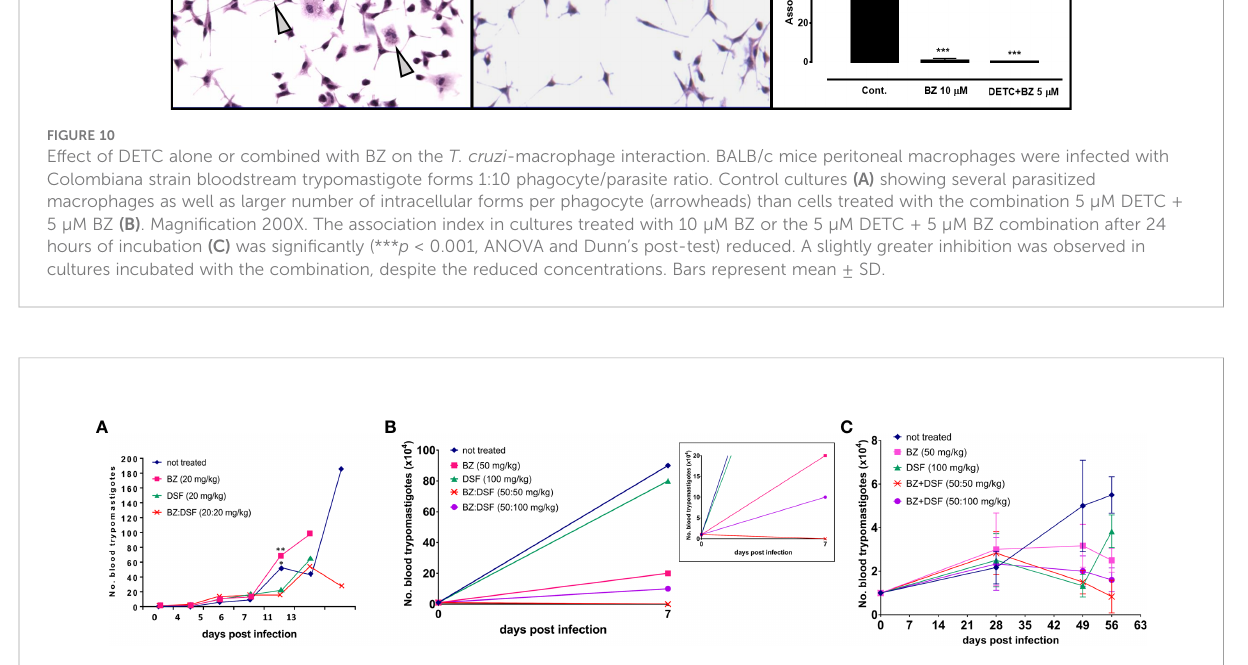
FIGURE 11 Parasitemia of Swiss Webster mice infected with T. cruzi blood trypomastigotes, Y strain (A, B) and Colombiana (C) . The animals were infected with 10 4 blood trypomastigotes/mL, strain Y, treated for 60 days with vehicle; low doses of BZ (20 mg/kg); DETC (20 mg/kg) or a combination of BZ + DETC (20:20 mg/kg), orally. * p < 0.05 and ** p < 0.01 ANOVA test and Dunn ’ s post-test (A) . Parasites treated with vehicle; BZ (50 mg/kg); DSF (50 mg/ kg); combination of BZ + DSF (50:50 mg/kg); and BZ + DSF (50:100 mg/kg), administered for 10 consecutive days (B , C , p > 0.05 ) . Insert shows data